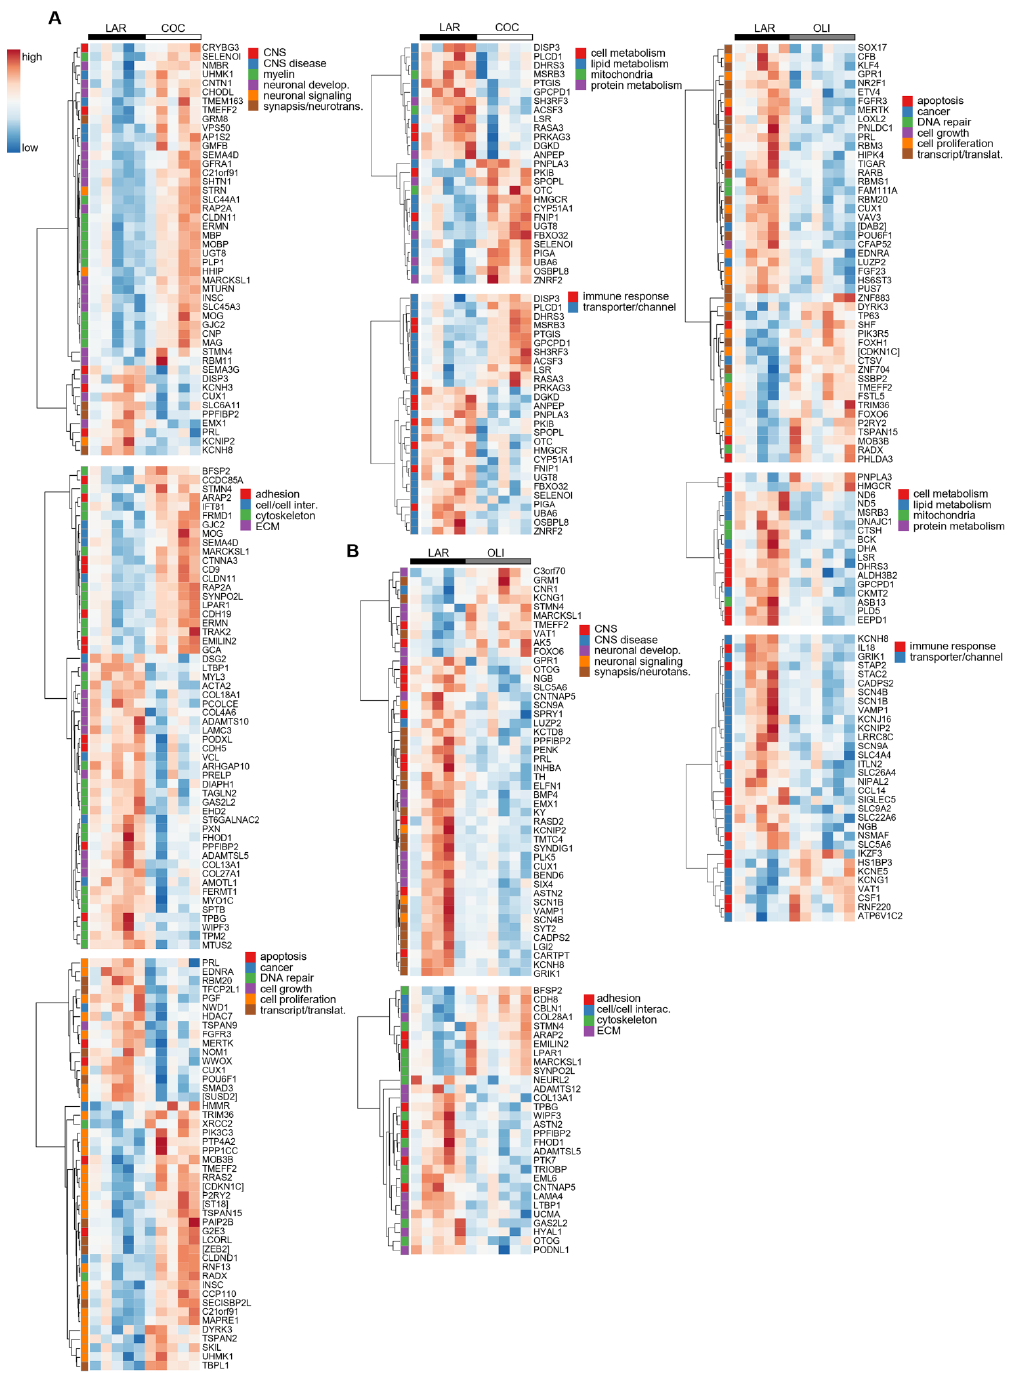
Figure 7. Heat maps of differentially expressed genes (5% FDR) between LAR and COC ( A ) and LAR and OLI ( B ) in the frontal cortex of juvenile Iberian pigs on d 70 of the study. RNA libraries were sequenced using a 2 × 150 bp Paired-End configuration of the Illumina HiSeq 4000 system on two flow cell lanes. The read counts were normalized using the trimmed means of M values (TMM) method implemented in edgeR and then analyzed with a generalized linear model, with an assumption of a negative binomial distribution. Columns represent individual pigs and rows represent log-transformed read counts per million for each gene. Blue and red colors represent the row minimum and maximum values, respectively. COC, coconut oil diet; FDR, false discovery rate; LAR, lard diet; OLI, olive oil